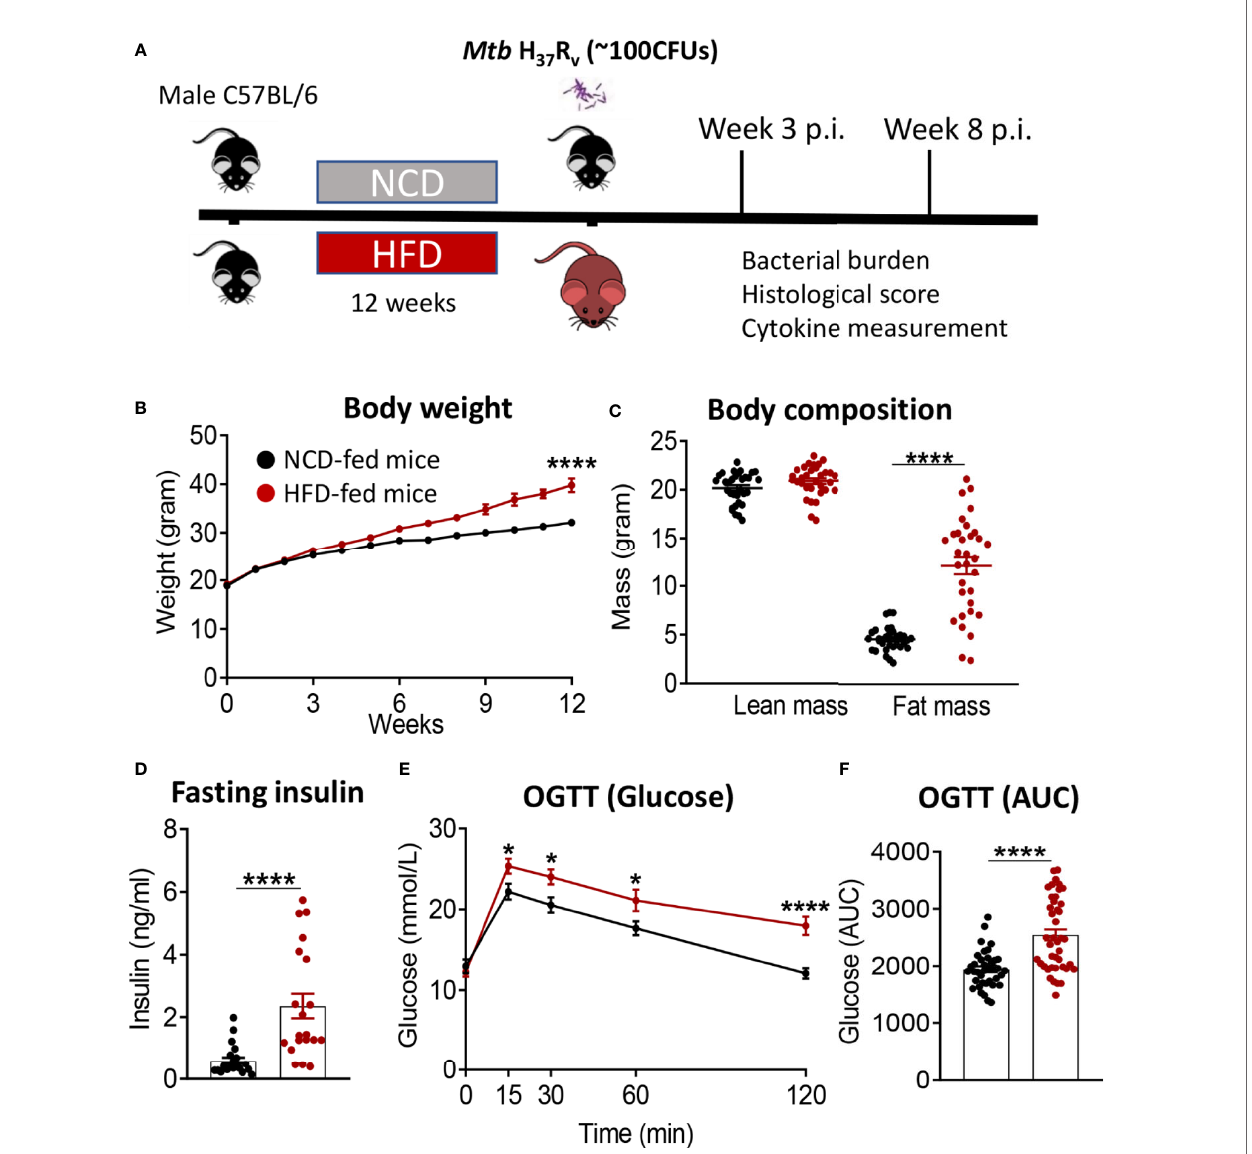
FIGURE 1 | Murine model of pre-diabetes. (A) Experimental design. (B) Body weight of mice fed NCD (black) or HFD (red) (n=30mice/group); (C) Body fat and lean mass at 12 weeks; (D) fasting insulin at 12 weeks (n=20 mice/group); (E) Blood glucose concentrations at baseline, 15, 30, 60, 120 minutes after oral glucose administration; (F) OGTT Area under curve (AUC) (n=30 mice/group). Data are means ± SEM. Data analysis was performed by Mann-Whitney U test. *p < 0.05 and ****p <